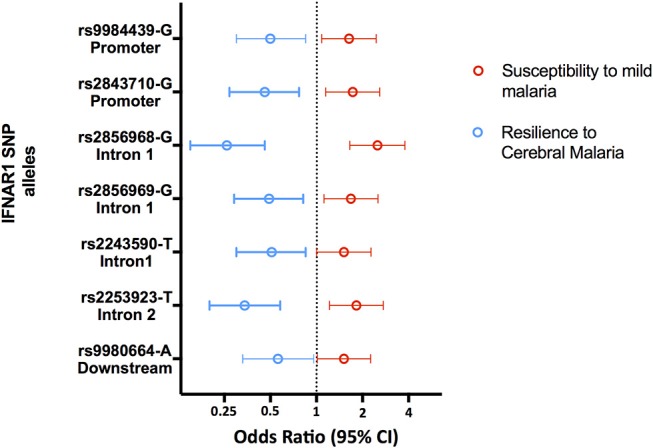
Opposing genetic effects of IFNAR1 SNP alleles in cerebral malaria and mild malaria. Genetic effects of minor frequency alleles at seven IFNAR1 SNPs in an Angolan dataset (136). Blue symbols represent the Odds Ratio and confidence intervals obtained by comparing 110 cases of CM and 129 mild malaria patients (OR< 1 corresponds to increased CM resilience). Red symbols represent the Odds Ratio and confidence intervals obtained by comparing 129 patients with mild malaria and 305 uninfected controls for the same alleles (OR > 1 corresponds to increased mild malaria susceptibility).